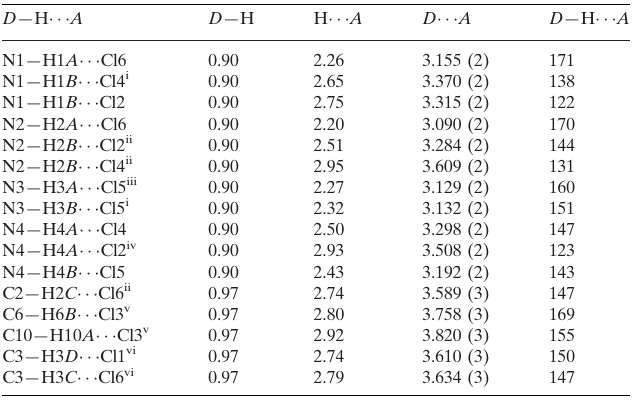
Hydrogen-bond geometry (A˚ , (cid:3)